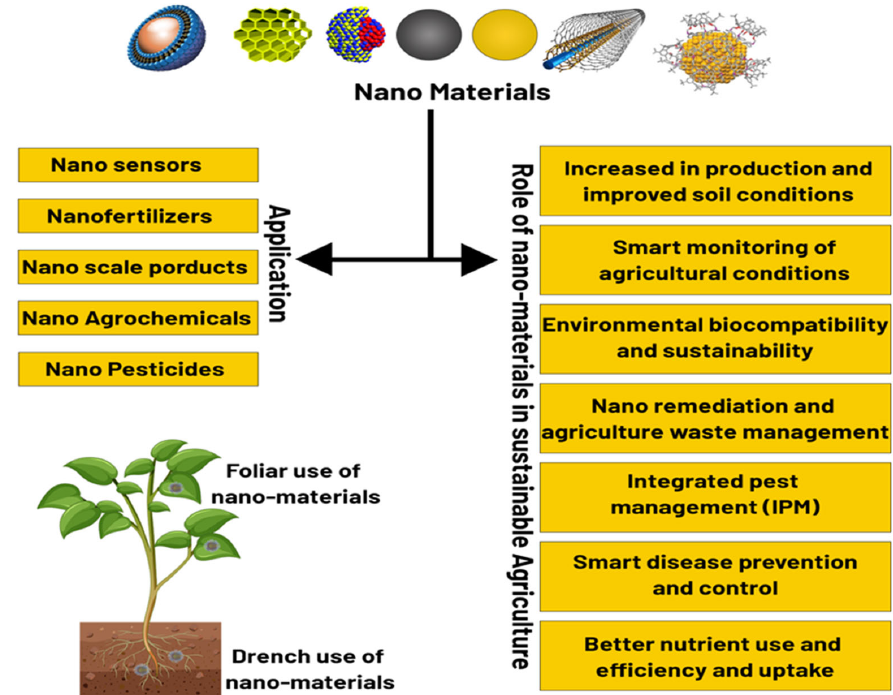
Figure 1. Possible role of nanomaterials in sustainable